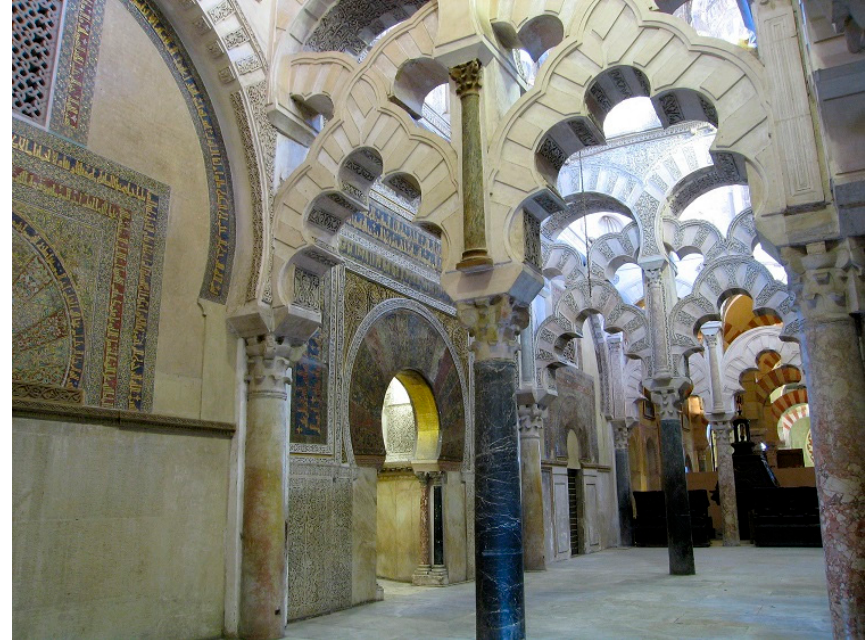
Figure 4. Great Mosque of Cordoba. Three domed triple bays of the maq ṣ ū ra in the caliphal enlargement. © Photo took by author.